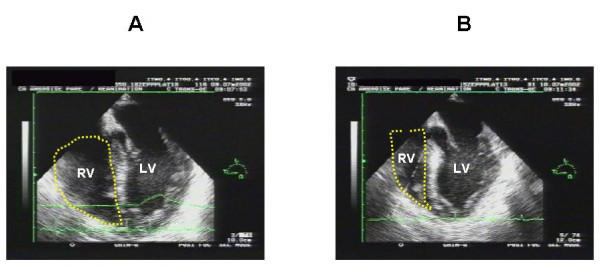
Long-axis view of the left ventricle by a transesophageal approach in a patient ventilated for septic shock. At day 1 (panel A), the patient had right ventricular dysfunction illustrated by major dilatation of the right ventricle. At day 2 (panel B), this was corrected. RV, right ventricle; LV, left ventricle.